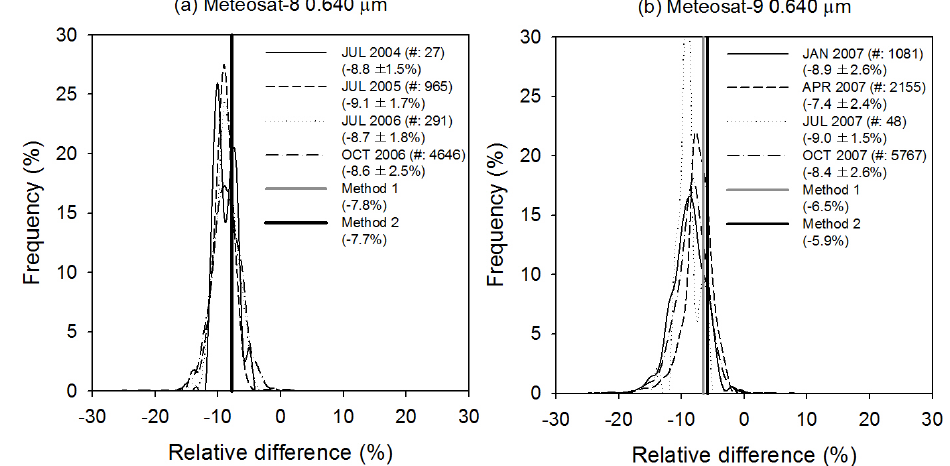
Fig. 9. Monthly frequency histograms of relative differences between measured and simulated reflectances for SEVIRI 0.640-µm channel of (a) Meteosat-8 and (b) Meteosat-9 from Method 3. The difference is calculated at each DCC pixel, from which monthly histogram is obtained. The number of DCC pixels used for each month is given in brackets (e.g., 27 pixels are used for July 2004) of the legend, and monthly mean and standard deviation of the differences are given below the number of pixels (e.g., mean and standard deviation of July 2004 are − 8.8% and 1.5%, respectively). For the comparison of three methods, mean biases inferred from Methods 1 and 2 are also given with grey and black vertical lines,